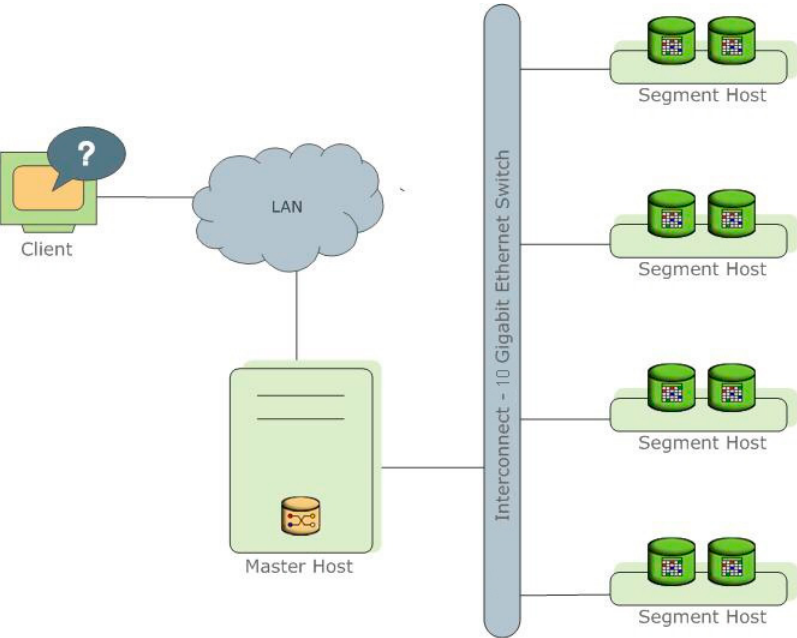
Figure 2. High-level Greenplum database architecture. Greenplum was a successful commercial OLAP product and is now open source; in addition, owing to the PostgreSQL project, it has complete support for spatial data features.